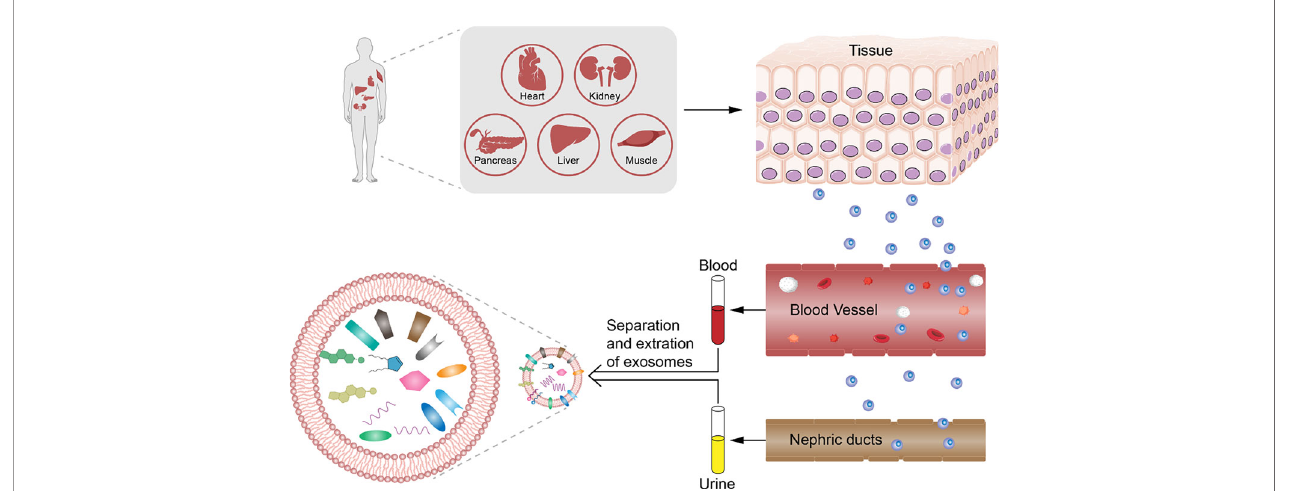
FIGURE 1 | Analysis of exosomes from patients with diabetes mellitus. Diabetes mellitus and diabetic complications have pathological change before organic damage in exosomes derived from body fl uids. We can collect the serum, plasma, and urine non-invasively and analyze the counts and contents such as DNA, RNA, and protein depending on the differences between healthy control by choosing the signi fi cant biomarker for early diagnosis of diabetes mellitus and diabetic